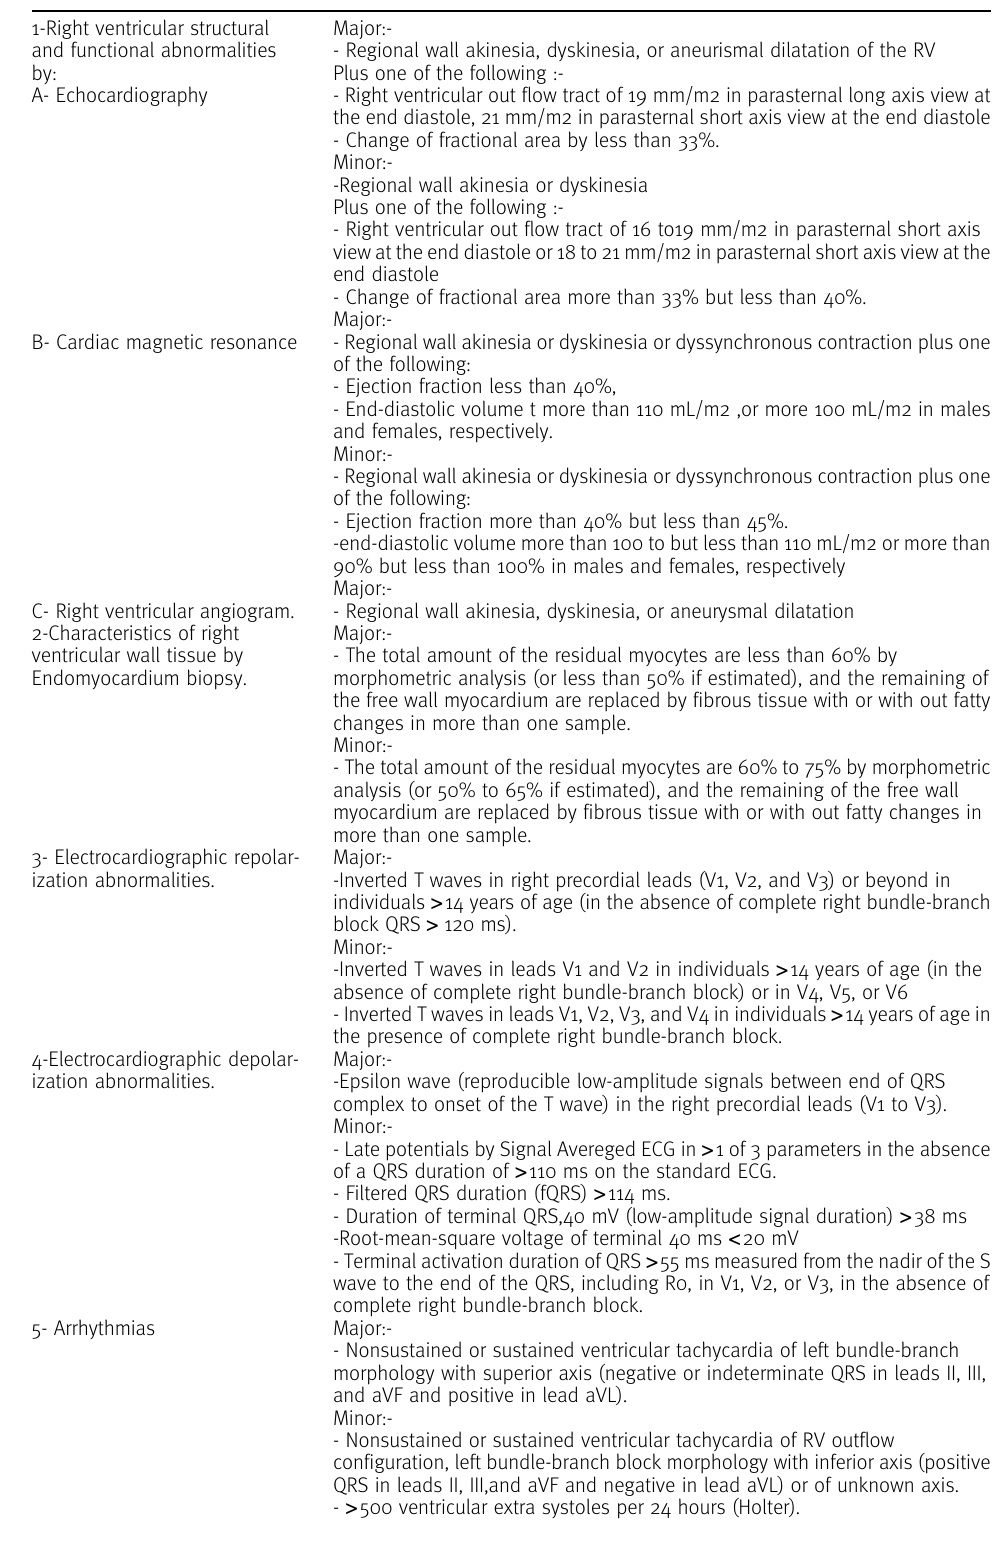
Table 2. Revised 2010 Task Force critiria for diagnosis of ARVC. Definite diagnosis: 2 major or 1 major and 2 minor criteria or 4 minor from different categories; borderline: 1 major and 1 minor or 3 minor criteria from different categories; possible: 1 major or 2 minor criteria from different